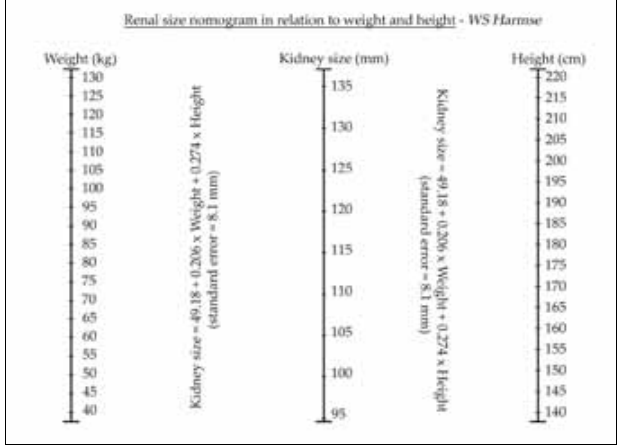
Fig. 8. Renal size nomogram in relation to weight and